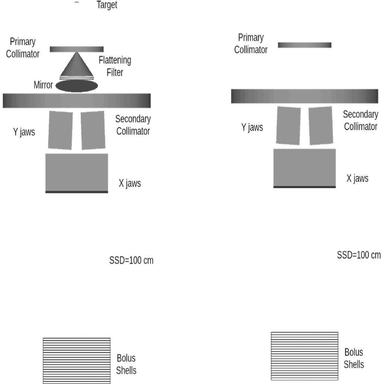
Monte Carlo model of LINAC head and water phantom model. The dose distribution in the build up zone was estimated with Monte Carlo using 1⋅1⋅1 mm3 voxels. (Left) Model for simulation with X-rays, (Right) Model for Irradiation with electrons.